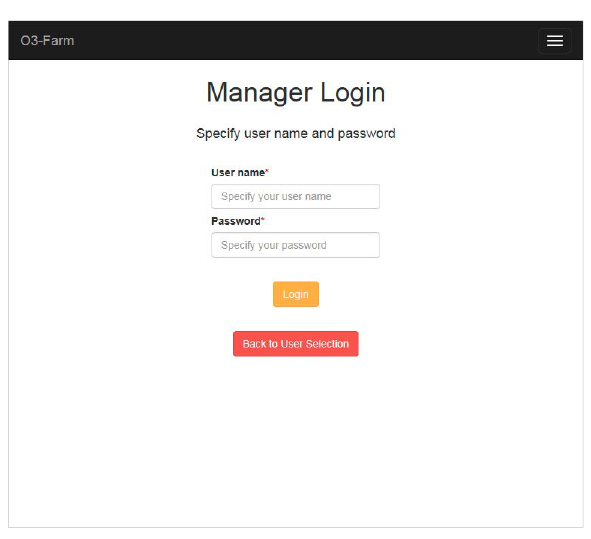
Figure 2. Example of a user login page.